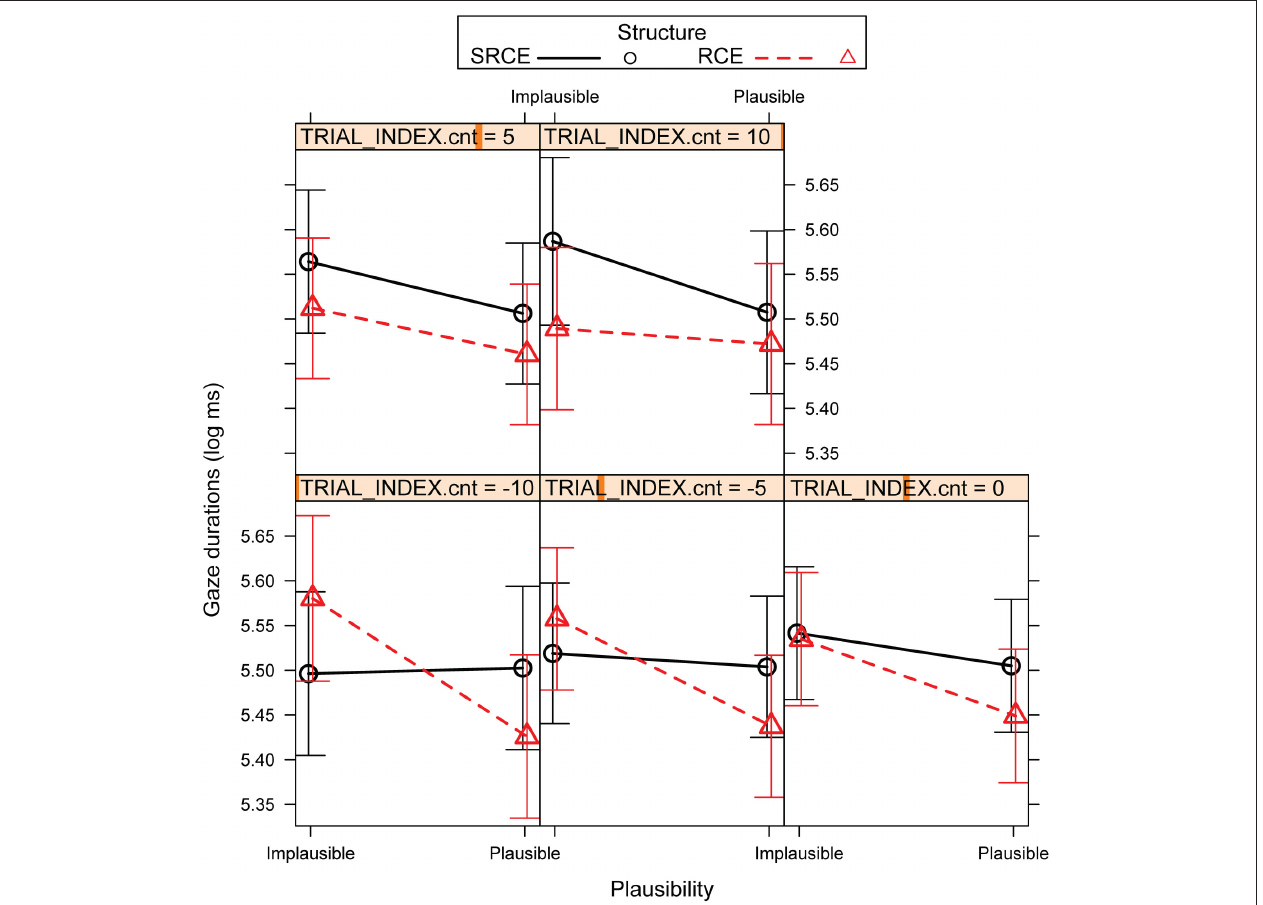
FIGURE 4 | Experiment 2 R01 estimated gaze durations (log ms): Structure by Plausibility by Trial interaction. Error bars represent the 95% confidence interval (CI) of the